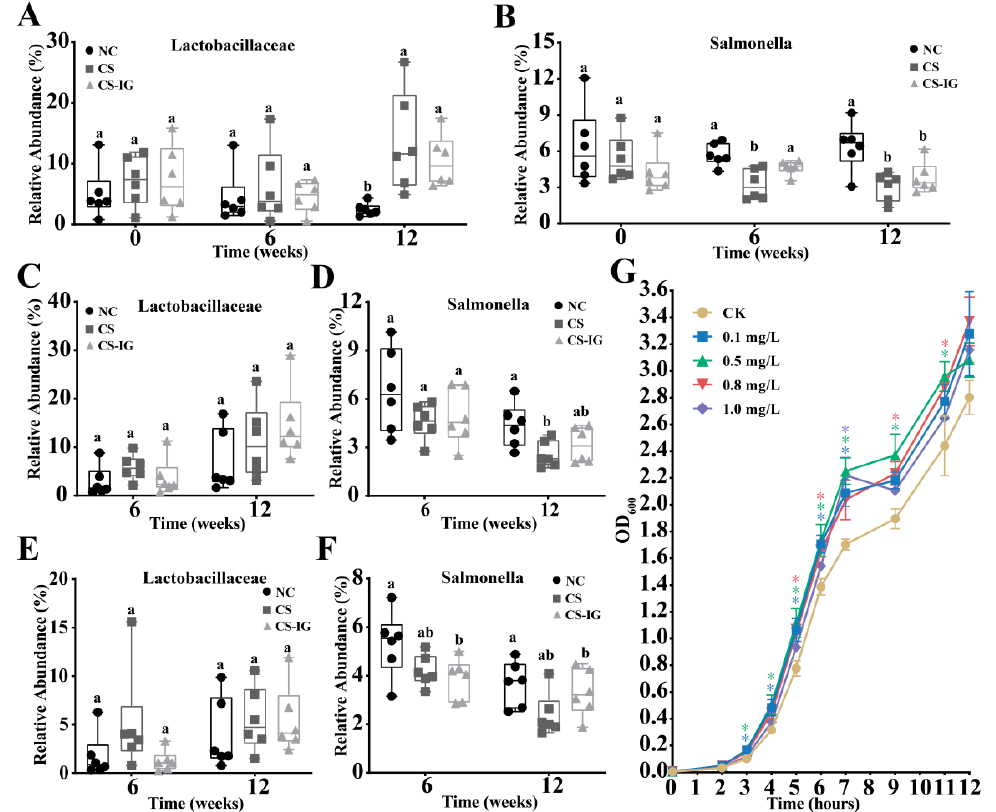
Figure 4. The relative abundance of Lactobacillaceae and Salmonella in gut microbiota of mice: ( A , B ) fecal, ( C , D ) colon, and ( E , F ) cecal contents. ( G ) Effects of different concentrations of nicotine on the growth of Limosilactobacillus sp. LM1. The strain LM1 was isolated from both feces and intestinal contents of mice. NC, mice treated with normal air exposure; CS, mice treated with cigarette smoke exposure; CS-IG, mice treated with combination of cigarette smoke exposure and intragastric administration of nicotine-degrading strain JQ581. Different letters indicate significant differences (Duncan’s test, n = 6, p < 0.05). Asterisks indicate significant differences (Duncan’s test, n = 3, p <